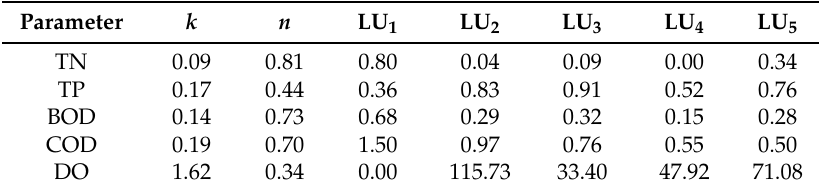
Figure 3. Comparison of observed and predicted pollutant loads in 30 river basins in Japan for the 6 year calibration period (1994–1999). The 1:1 line is plotted for comparison. Table 4. Estimated values of model parameters.